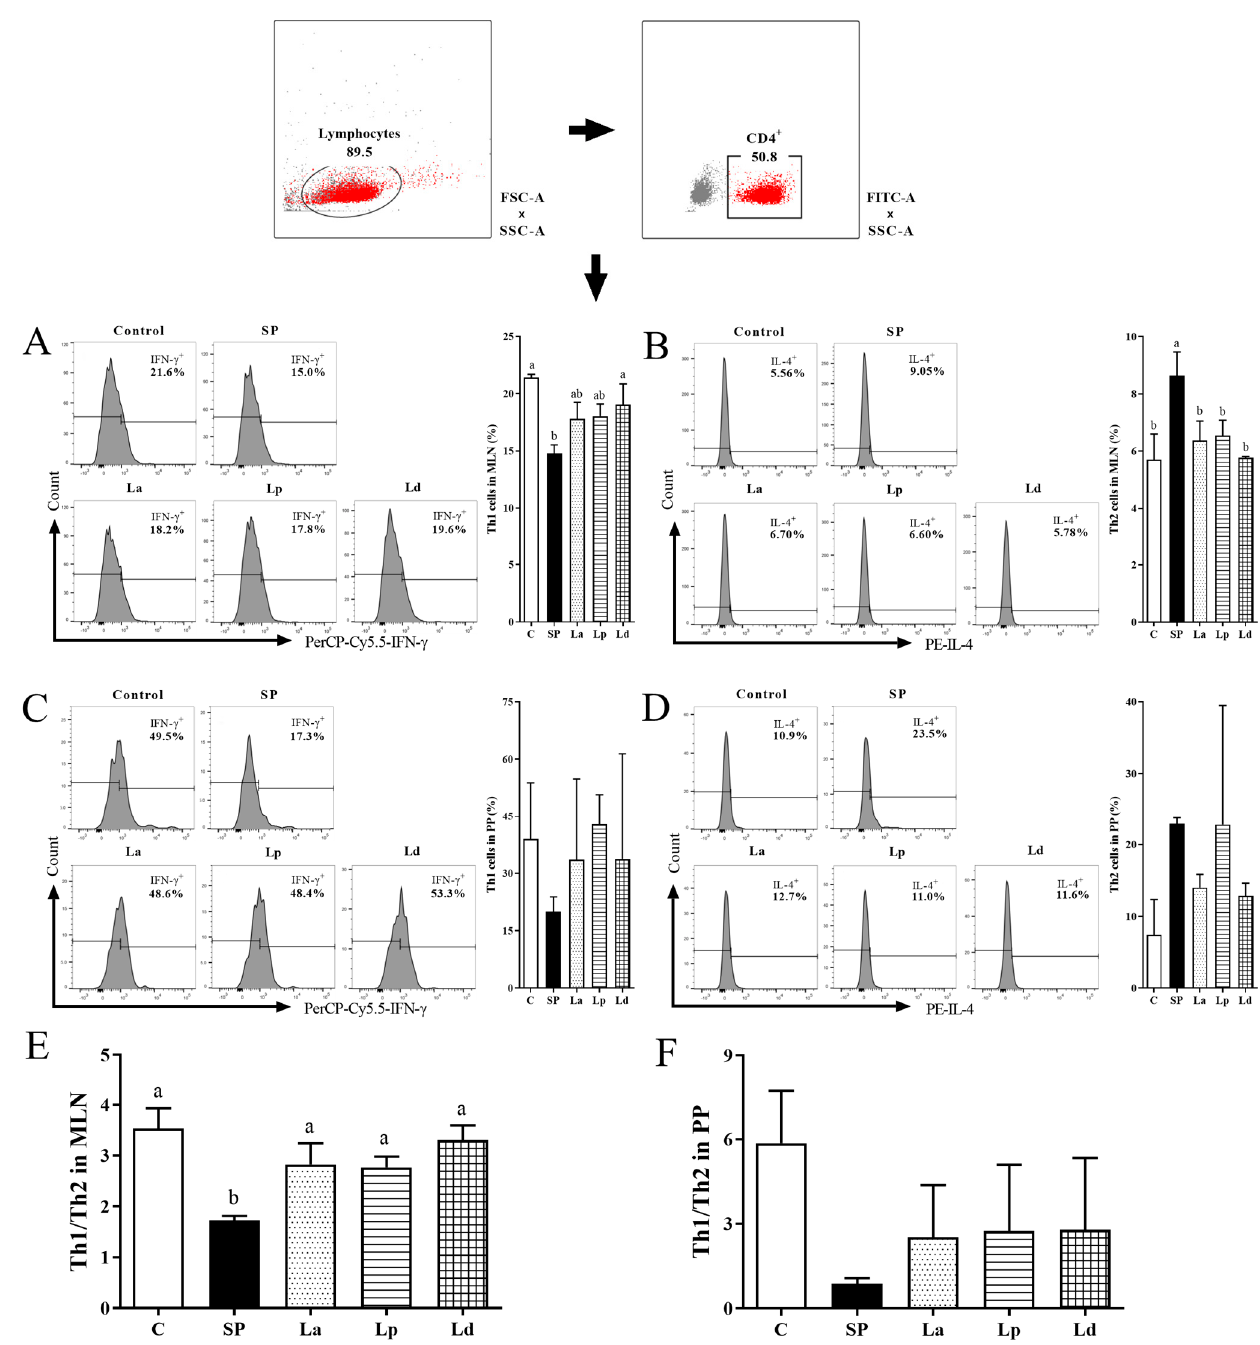
Figure 5. Effect of Lactobacillus on Th1/Th2 balance in MLNs and PPs of soy-allergic mice. The graph shows the percentage of Th1 ( A ), Th2 ( B ) cells among CD4 + T cells in MLNs, and Th1 ( C ), Th2 ( D ) cells among CD4 + T cells in PPs. Th1/Th2 in MLNs ( E ) and PPs ( F ) of mice was analyzed. Different letters denote statistically significant differences ( p < 0.05).